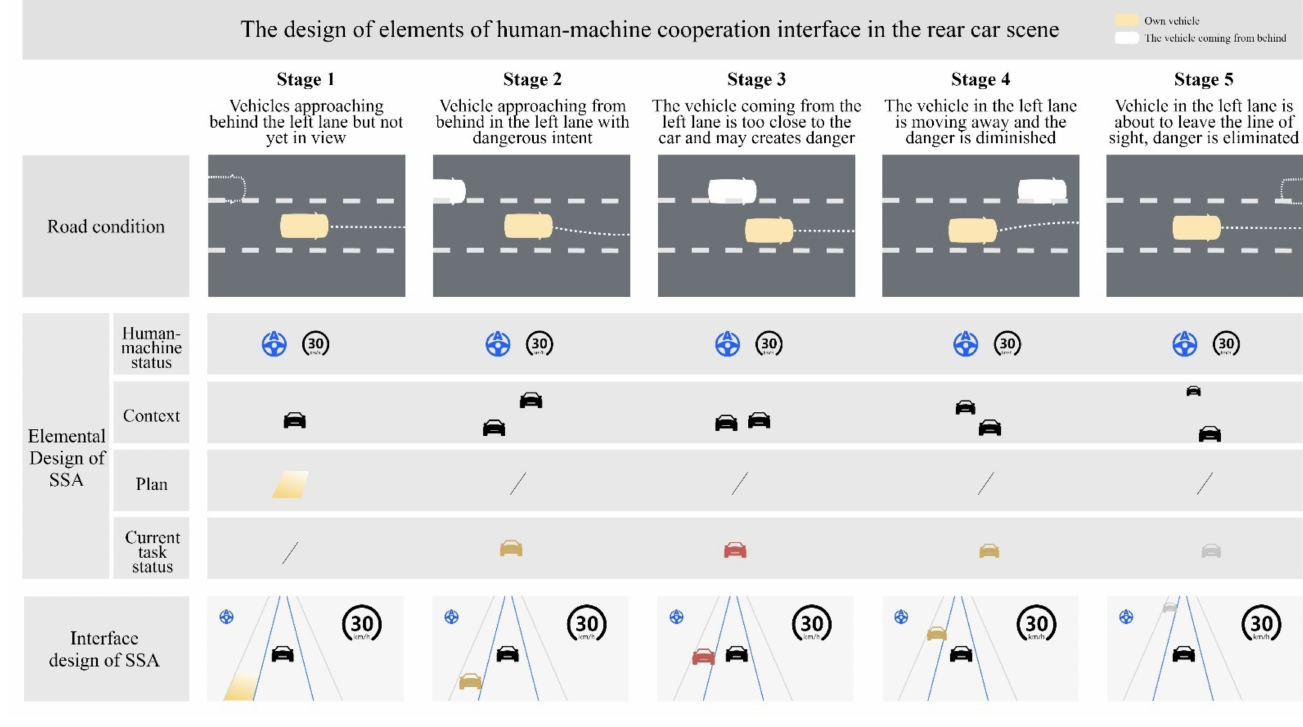
Figure 4. The design of elements of human–machine cooperation interface in the rear car